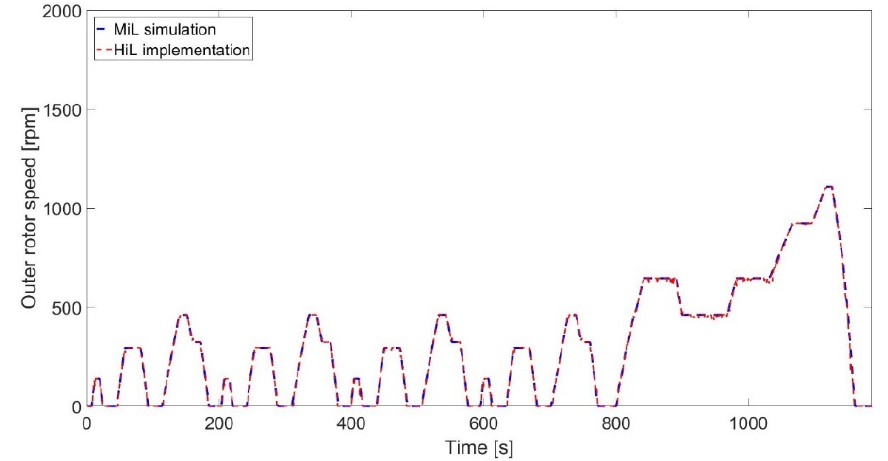
Figure 16. HiL (experimental) vs. MiL agreement results for the outer rotor speed, LPF-based EMS.